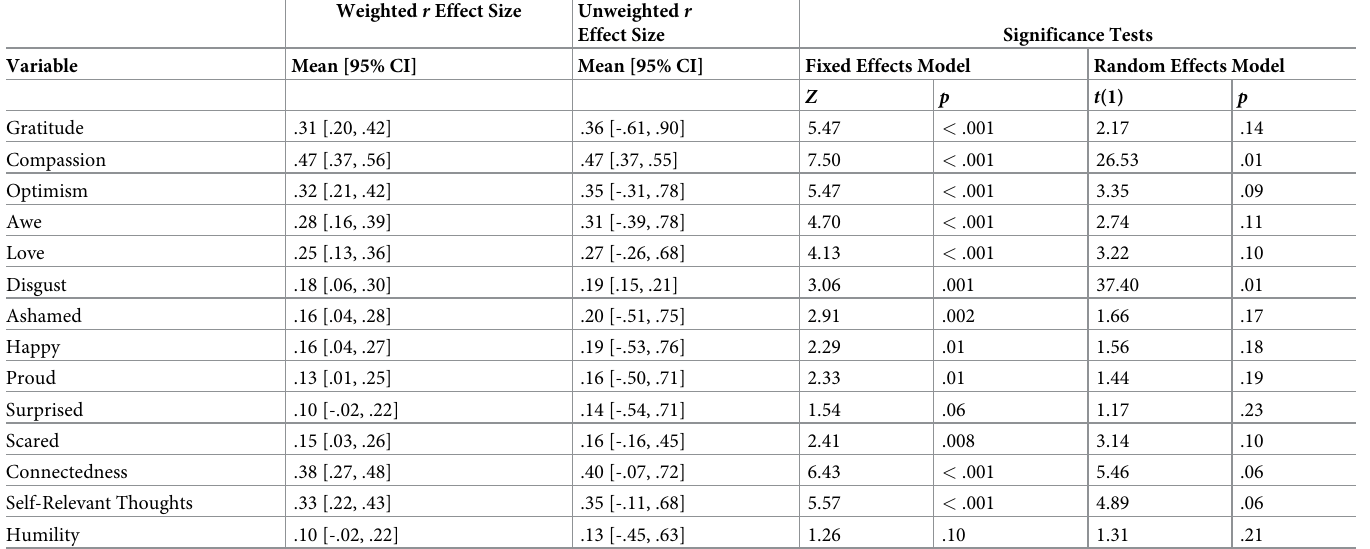
Table 7. Meta-analysis of Studies 1 and 2 ( k = 2, total N =